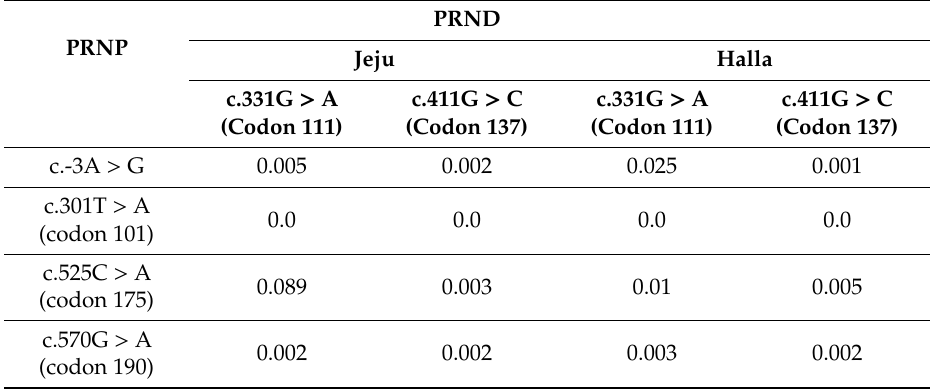
Table 6. Linkage disequilibrium (LD) between single nucleotide polymorphisms (SNPs) in the PRNP and PRND genes with r 2 values in Jeju and Halla horses.